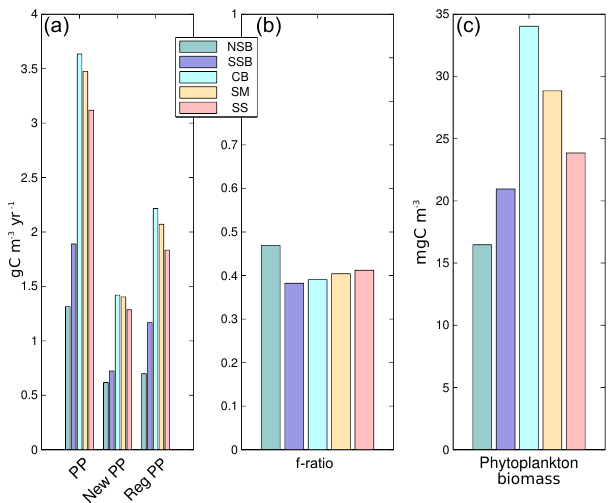
Figure 10. Spring mean (March–May) of (a) primary production (PP, g Cm − 3 yr − 1 ) , new production (g Cm − 3 yr − 1 ) and regen- erated production (g Cm − 3 yr − 1 ) , (b) f ratio (new and/or regen- erated production) and (c) phytoplankton biomass (mgCm − 3 ) in the offshore boxes. Each colour corresponds to a box (see legend): northern Saharan Bank (NSB), southern Saharan Bank (SSB), Cape Blanc area (CB), Senegalo-Mauritanian region (SM) and southern Senegal region